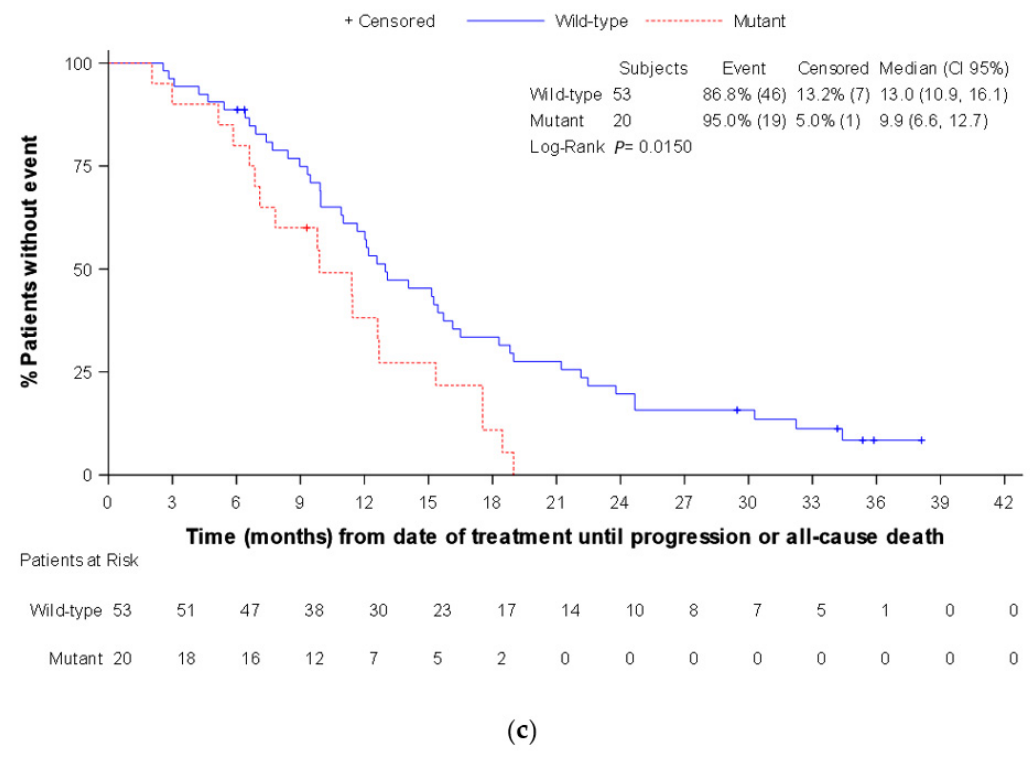
Figure 2. Progression free survival according to RAS mutational status in liquid biopsy at any time (panitumumab subpopulation, left tumor location): ( a ) mutant allele fraction ≥ 1% cut-off; ( b ) mutant allele fraction ≥ 0.1% cut-off; and ( c ) mutant allele fraction ≥ 0.02%